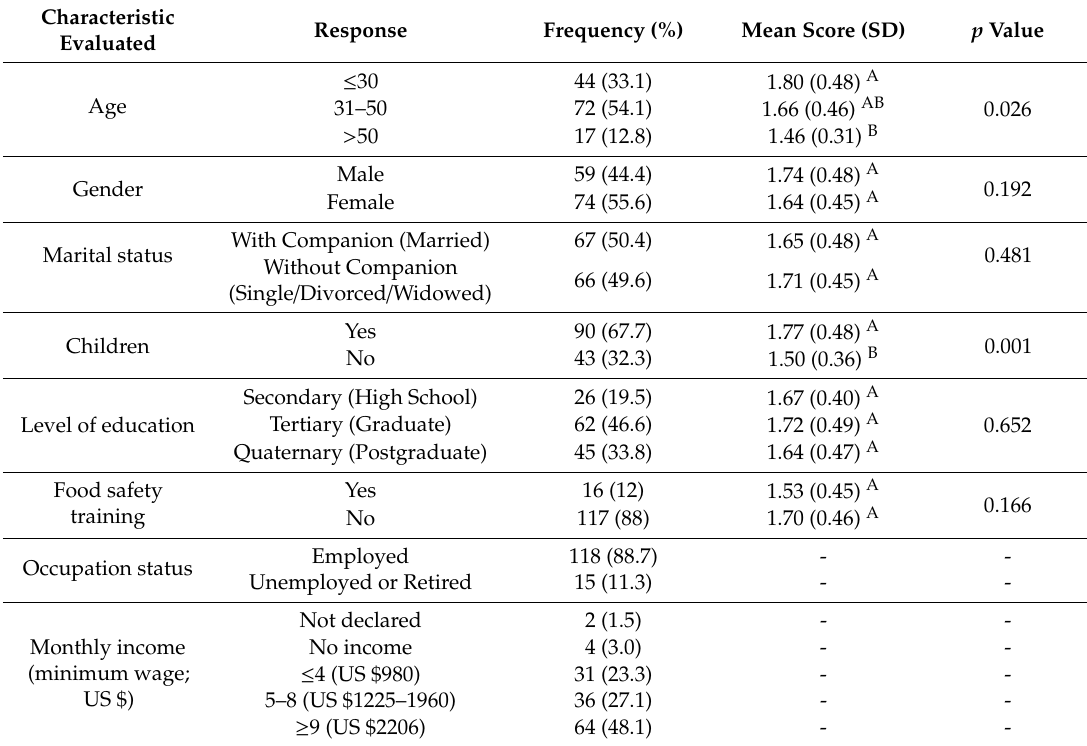
Table 1. Sociodemographic variables and their association with food safety importance perception scores of food truck consumers studied in the Federal District, Brazil ( n =